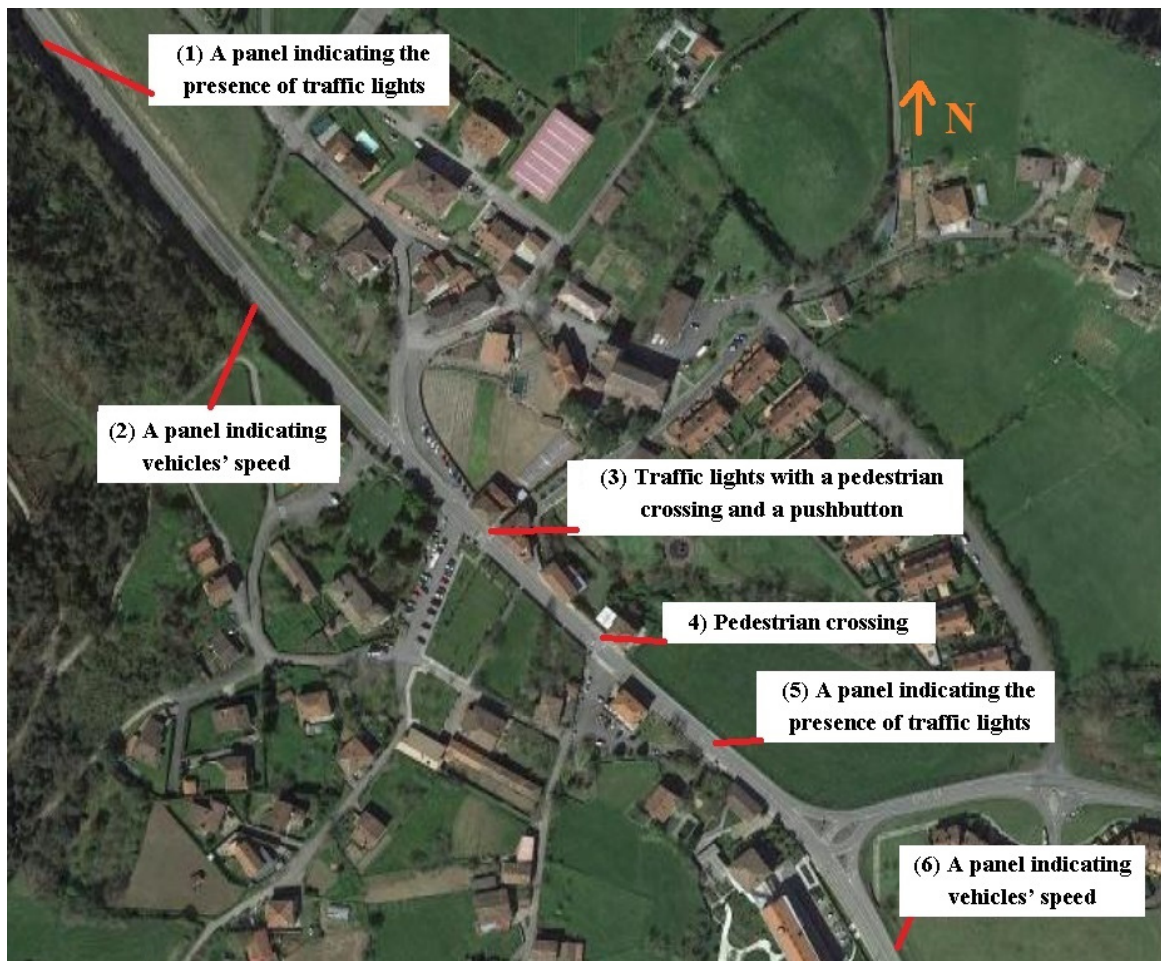
Figure 5. Locations of the traffic calming measures and other elements in Arrespalditza/Respaldiza (Spain).